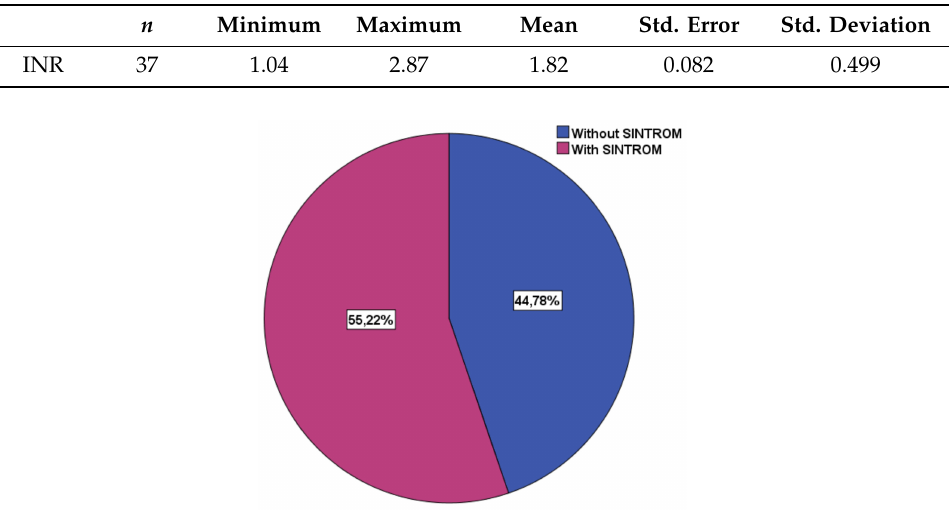
Figure 5. Percentage of patients on acenocumarol vs.